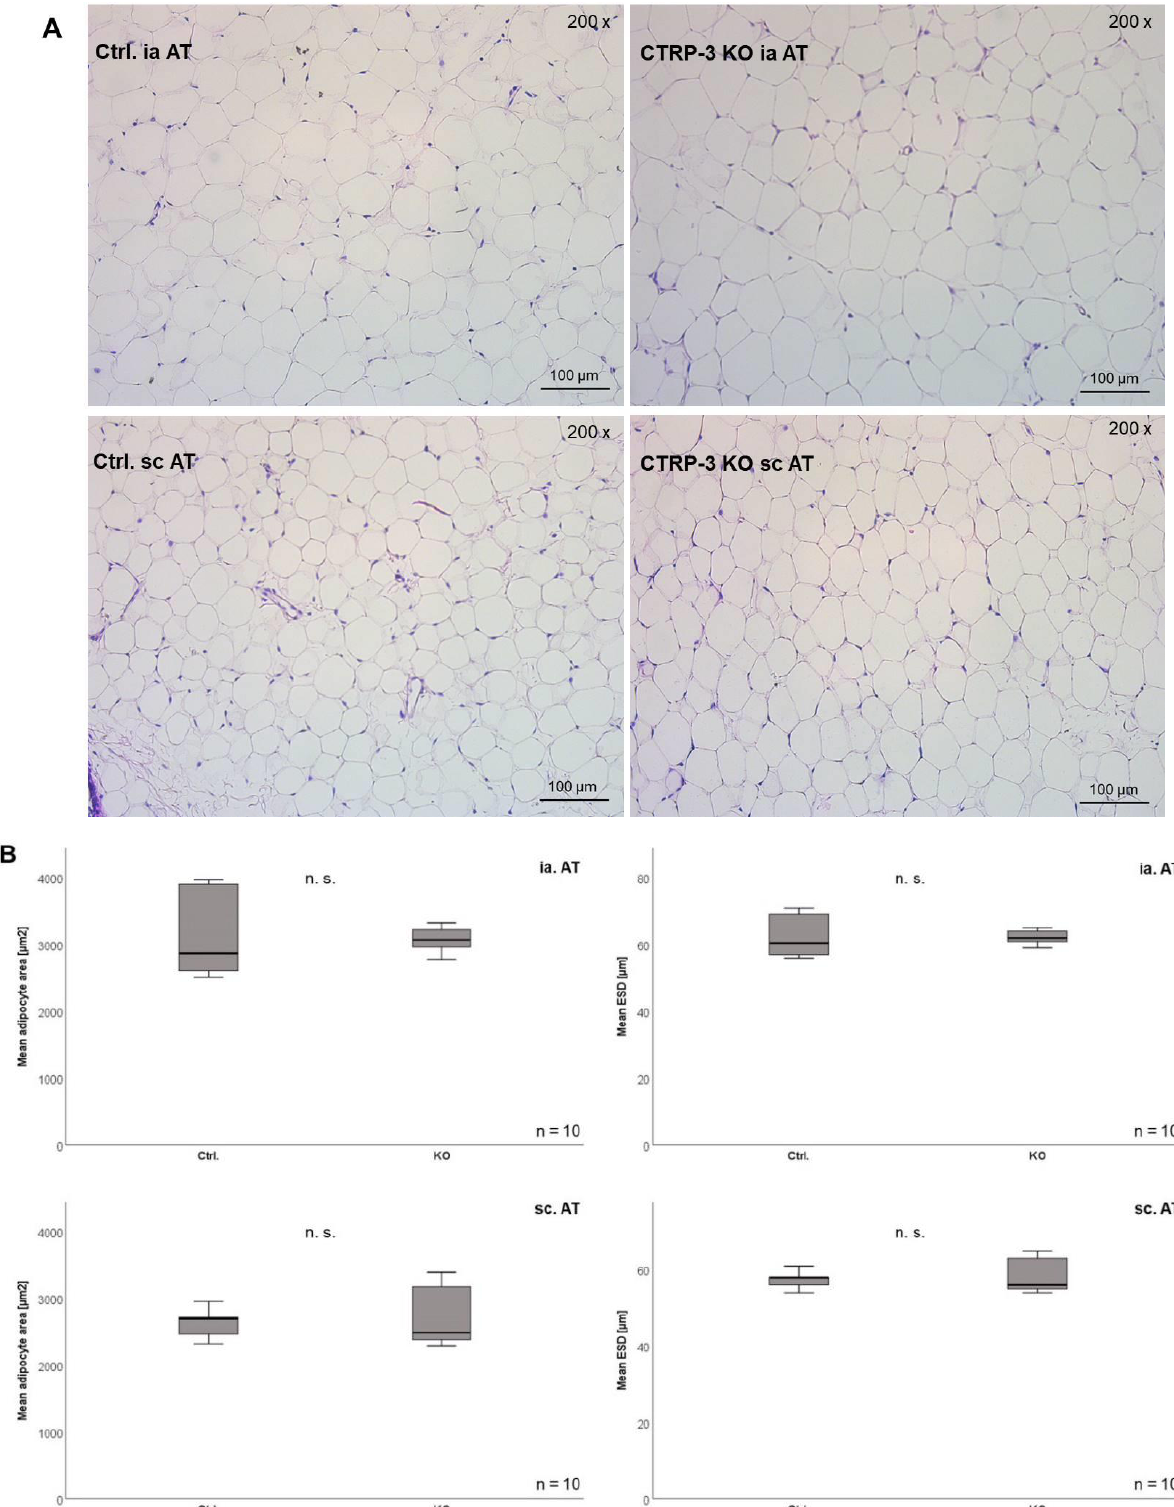
Figure 2. Histologic and quantitative examination of total subcutaneous and intra-abdominal adipose tissue cell morphology. Panel ( A ): Histologic slides after HE (hematoxylin–eosin) staining are shown (light microscopy; 200 × ). Panel ( B ): Quantitative analysis of mean adipocyte size ( µ m 2 ) and mean adipocyte estimated standard diameter (ESD, µ m). Ctrl., control animals; ia. AT, intra-abdominal adipose tissue; sc. AT, subcutaneous adipose tissue; KO, CTRP-3 knockout animals.